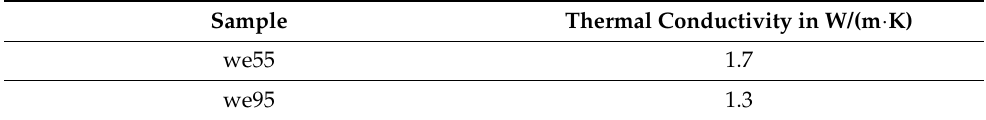
Table 6. Overall thermal conductivity measured with divided bar apparatus.